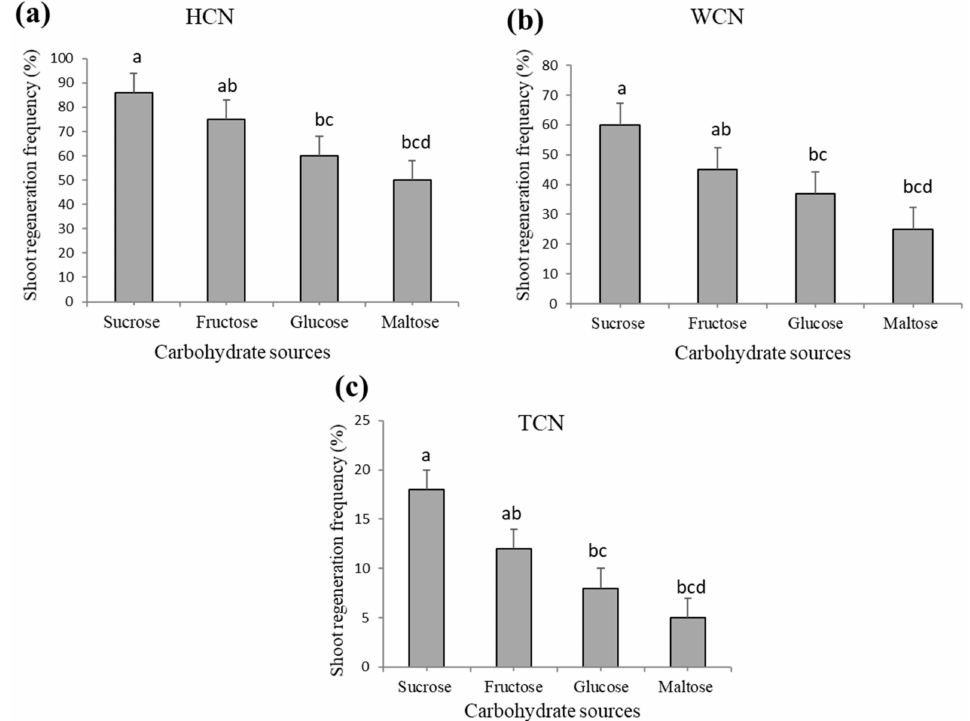
Figure 3. Shoot regeneration e ffi ciency of Lupinus albus from three di ff erent explants on four di ff erent carbohydrate sources after 4 to 5 weeks of culturing ( a ) HCN (half cotyledonary node), ( b ) WCN (whole cotyledonary node), ( c ) TCN (traditional cotyledonary node). Di ff erent letters show significant di ff erences at p 0.05. Data shown represent mean ± standard error of four